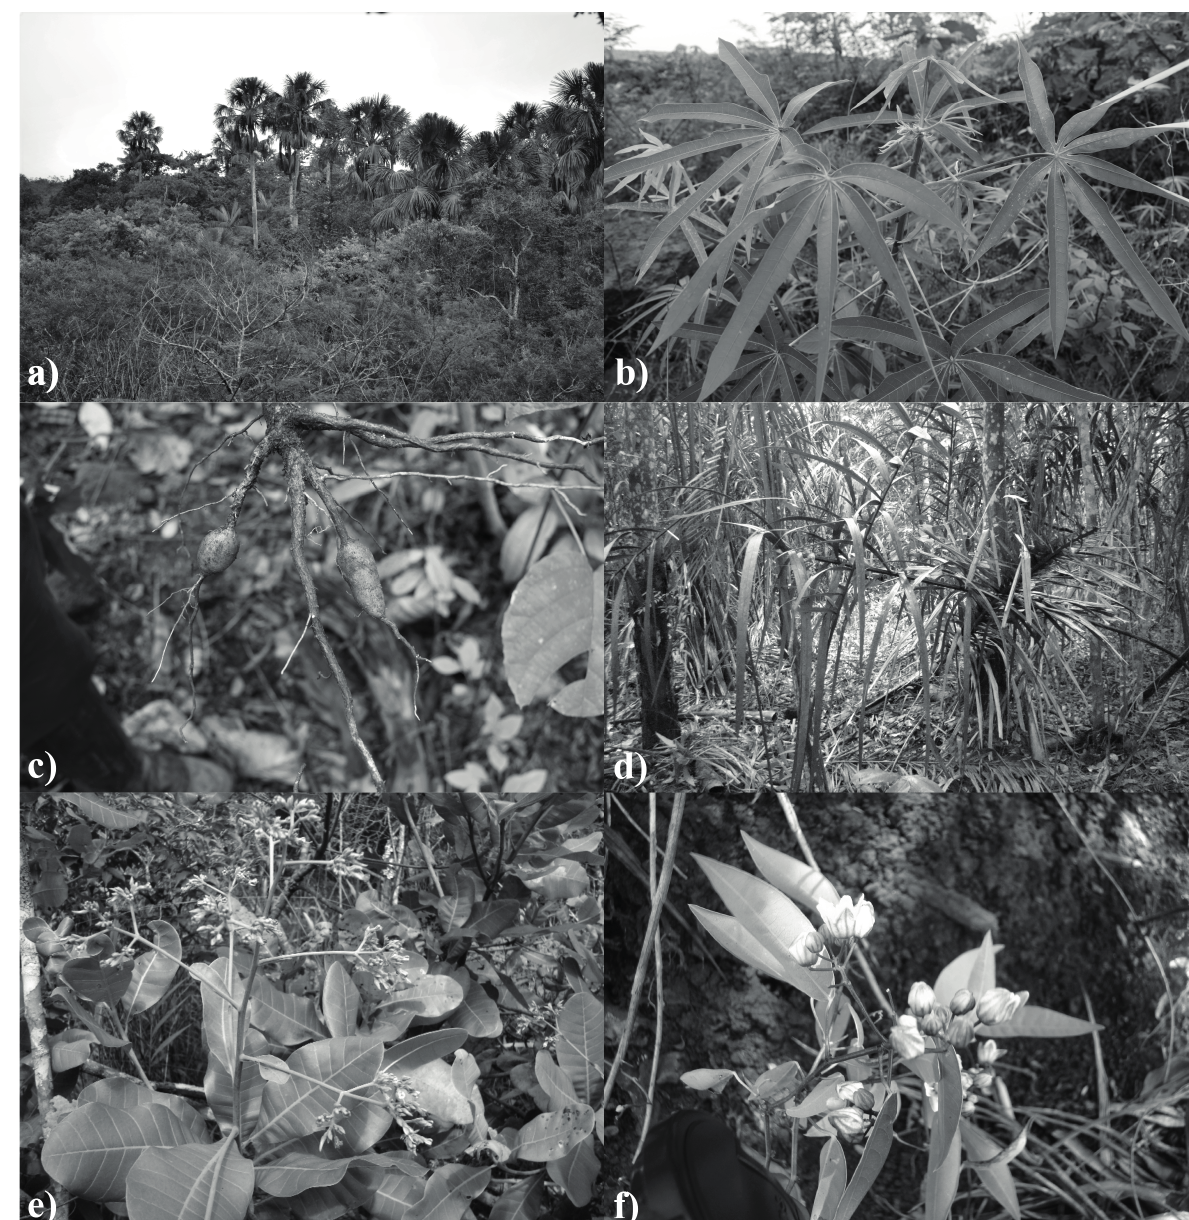
Figure 3 - Useful species recorded in archaeological sites in Serra de Carajás. a ) palm swamp; b and c ) natural regeneration of Manihot sp.; d ) Oenocarpus distichus in capão forests; e ) small agglomerations of Anacardium occidentale ; f ) Manihot